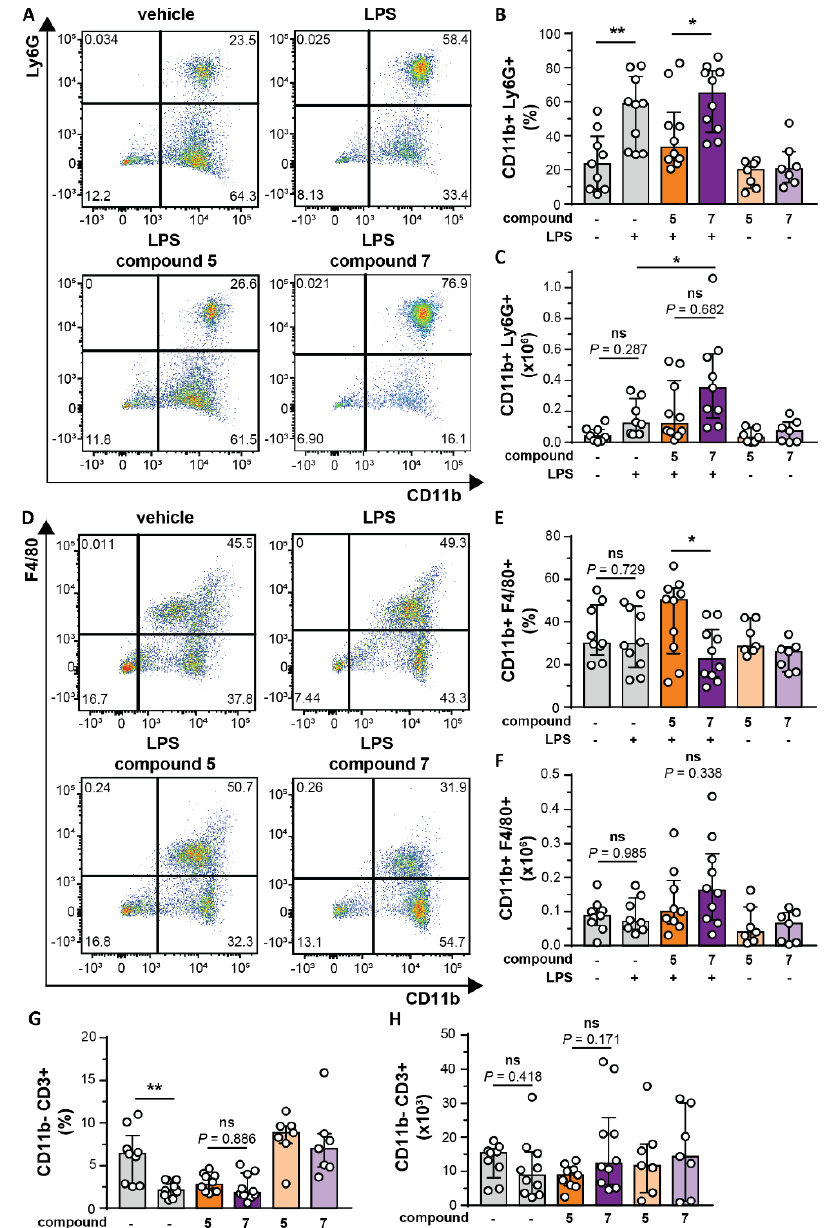
Figure 5. Effects of compounds 5 and 7 on in vivo chemotaxis of CD11b + Ly6G + , CD11b + F4/80 + and CD11b - CD3 + cells. ( A ) Neutrophil content of pouches from mice given a vehicle injection (top left), an LPS injection (top right), an LPS injection and compound 5 (bottom left) or an LPS injection and compound 7 (bottom right). Flow cytometry plots represent the distribution of live cells based on surface CD11b and Ly6G staining; ( B ) analysis of the percentage of neutrophils (CD11b+Ly6G+) recruited to air pouches; ( C ) total number of neutrophils (CD11b+Ly6G+) migrated to subdermal air pouches; ( D ) macrophage content of pouches from mice given a vehicle injection (top left), an LPS injection (top right), an LPS injection and compound 5 (bottom left) or an LPS injection and compound 7 (bottom right). Flow cytometry plots represent the distribution of live cells based on surface CD11b and F4/80 staining; ( E ) analysis of the percentage of macrophages (CD11b+F4/80+) recruited to air pouches. ( F ) Total number of macrophages (CD11b+F4/80+) migrated to subdermal air pouches. ( G ) Analysis of the percentage of T-cells (CD11b-CD3+) recruited to air pouches. ( H ) Total number of T- cells (CD11b-CD3+) migrated to subdermal air pouches. Air pouches contain compound 5 (5 µg) and compound 7 (5 µg) in the presence or absence of LPS (2 µg). Each data point represents a single mouse ( n = 7–10). * p < 0.05, ** p < 0.01. Bars represent mean values. Data were pooled from three independent experiments. +/- signs indicate, respectively, the presence or absence of LPS (2 µg).